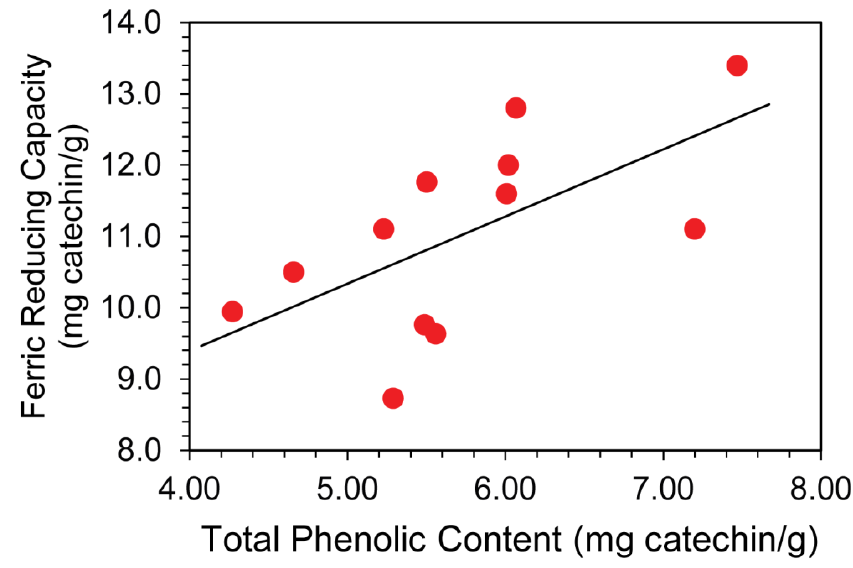
Figure 1. A positive correlation exists between the FRAP assay and Folin–Ciocalteu assay indicating that antioxidant capacity is closely coupled to total phenolic content, r = 0.720 (p <0.05).